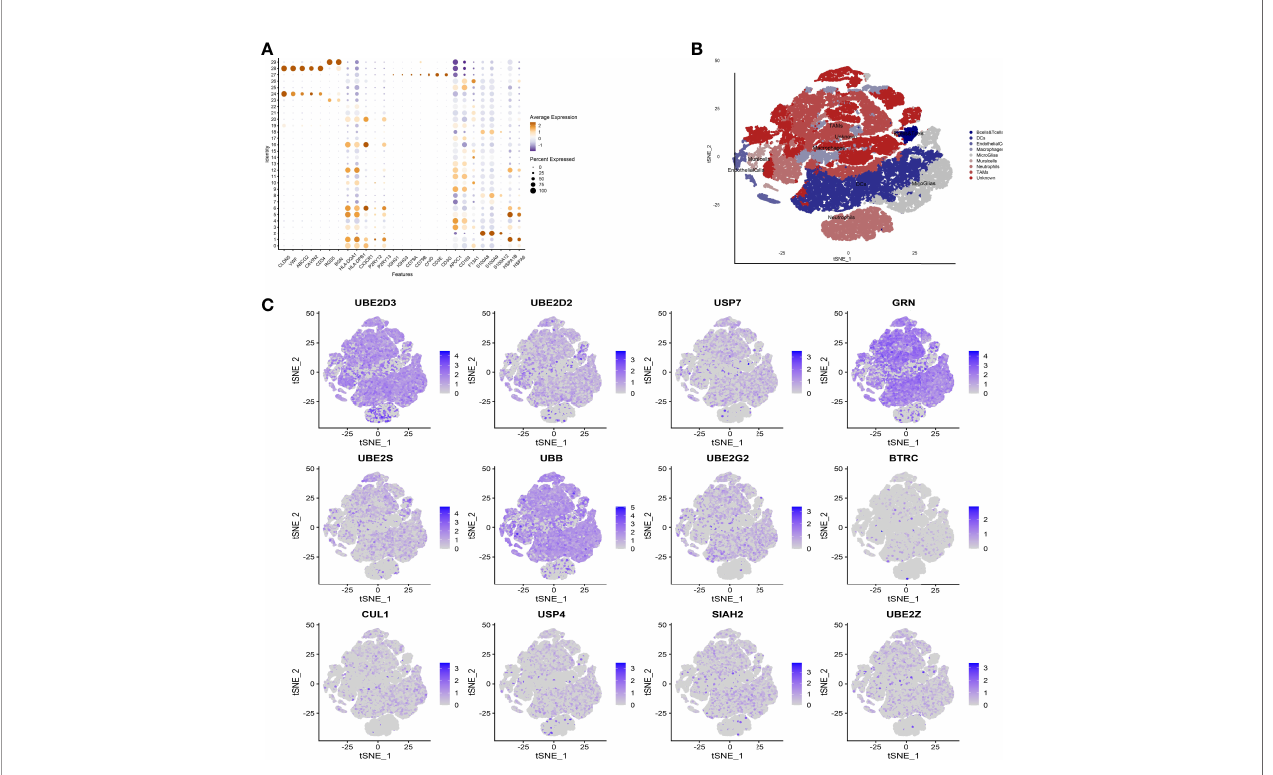
FIGURE 8 | Expression of model genes at single cell level. (A) After dimension reduction and the tSNE clustering, the immune cells were identi fi ed using their feature genes. (B) The cells were divided into approximately 6 categories of cell types, namely endothelial cells(EC), neutrophils, T cells/B cells, mural cells, tumor-associated macrophages (TAMs), didenric cells and microglias. (C) The genes involved in the signature were identi fi ed in the single-cell tumor microenvironment atlas.